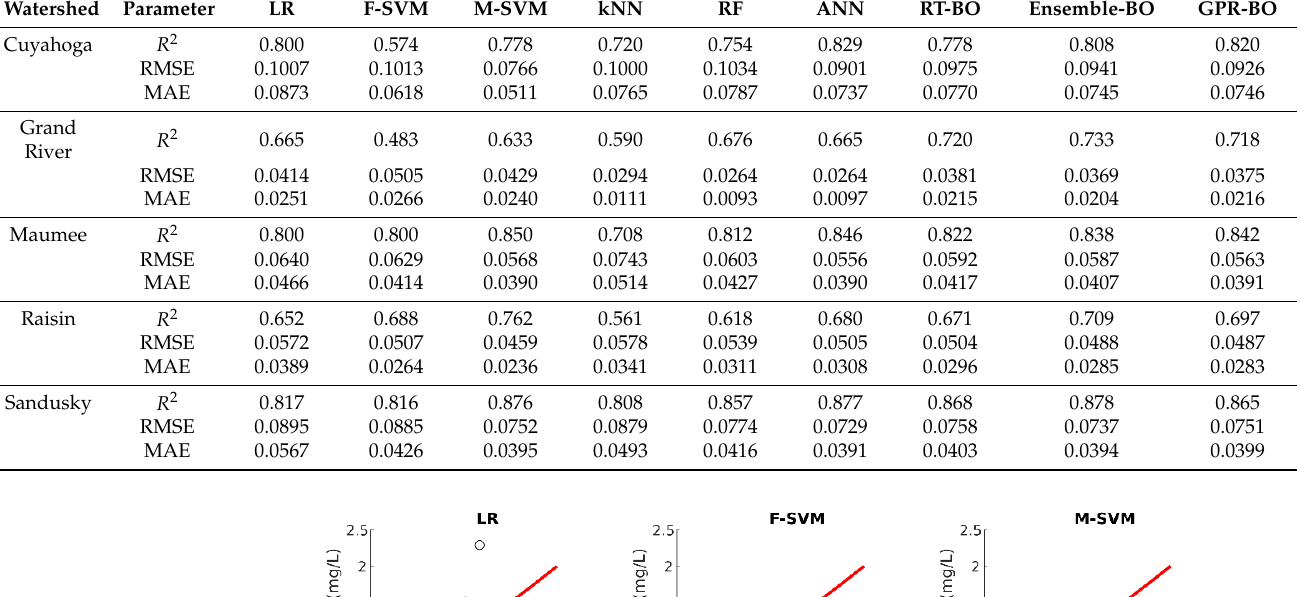
Table 6. Comparison of R 2 , RMSE, and MAE using different ML algorithms for phosphorus prediction on test dataset.